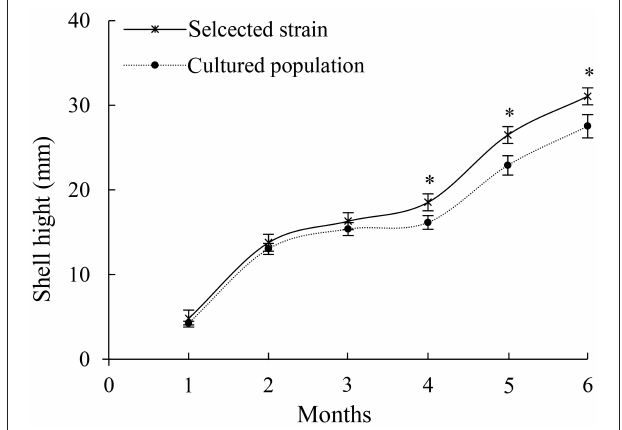
FIGURE 1 | Growth of shell height of selective strain and cultured population pearl oysters. * p <